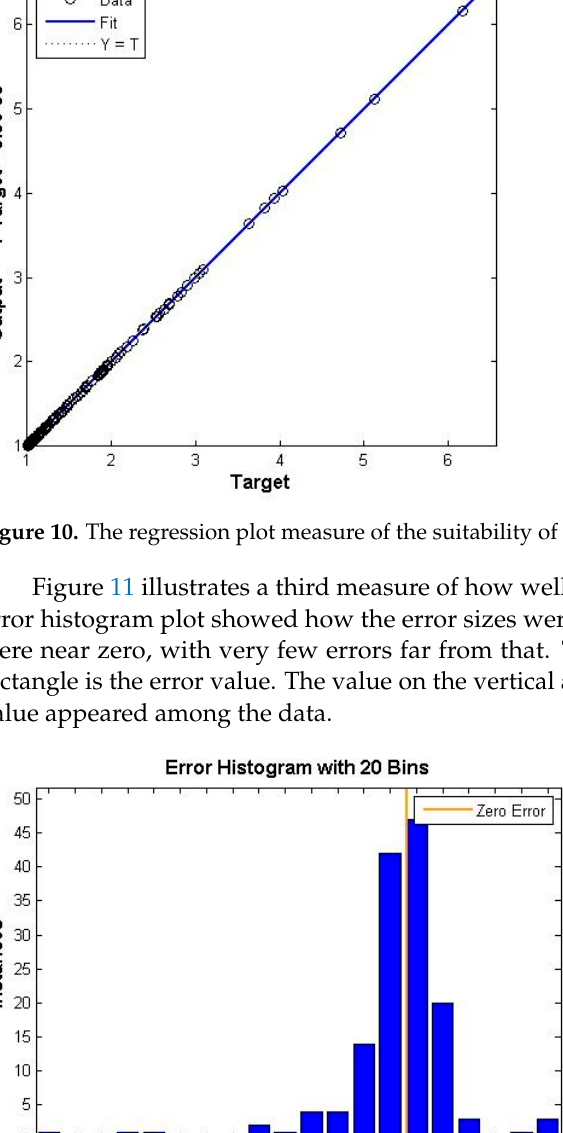
Figure 9. The mean square error of the network during the training epochs.